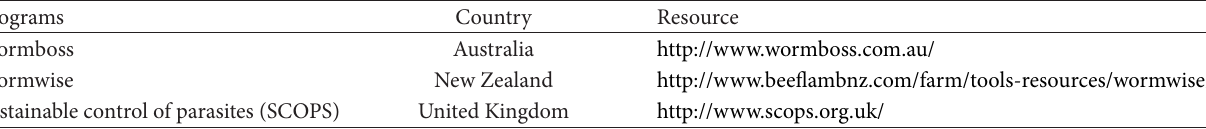
Table 1: Programs/guidelines promoting sustainable GIN parasite